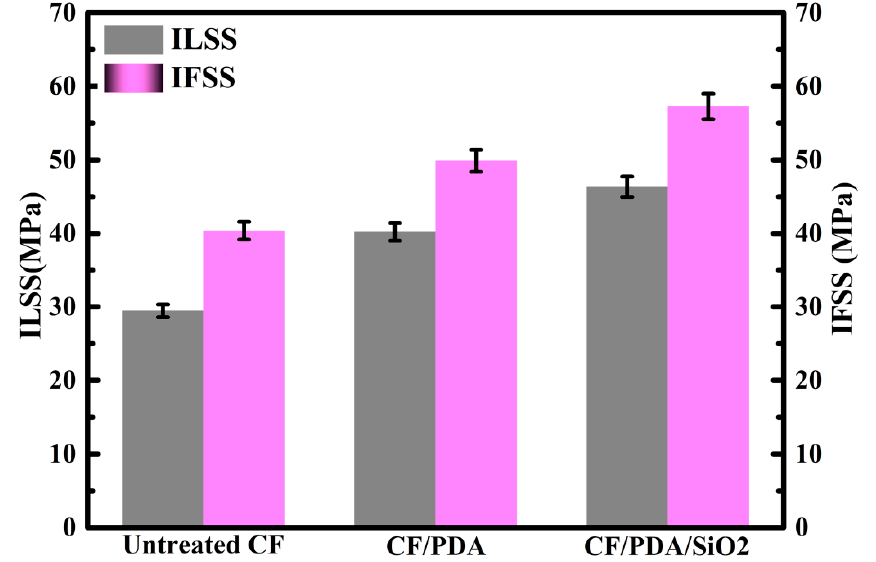
Figure 4. ILSS and IFSS results of composites.